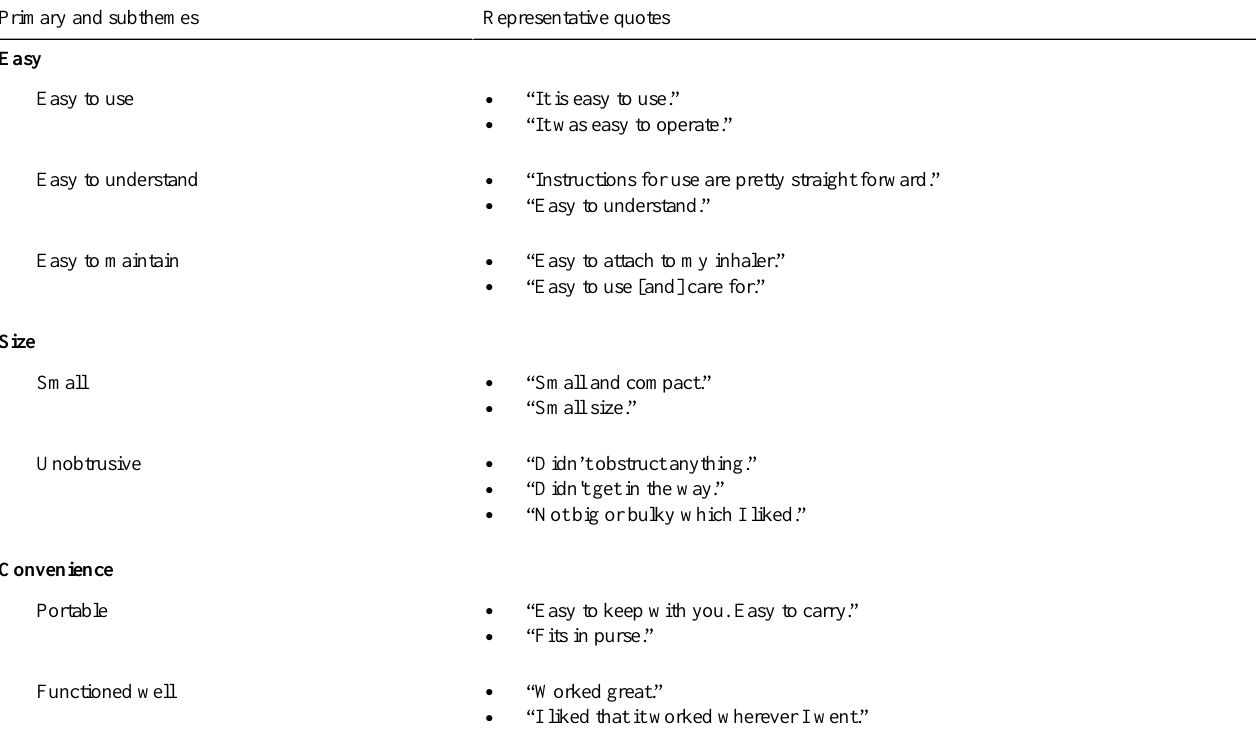
Table 3. Primary themes, subthemes, and selected excerpts from open-ended responses about participants’experience with the inhaler sensor device.